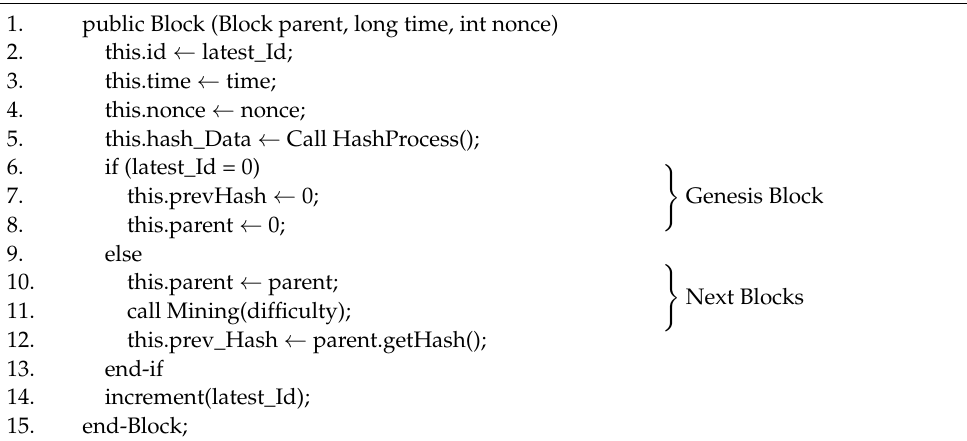
Algorithm 1: Creating block with mining process using difficulty.